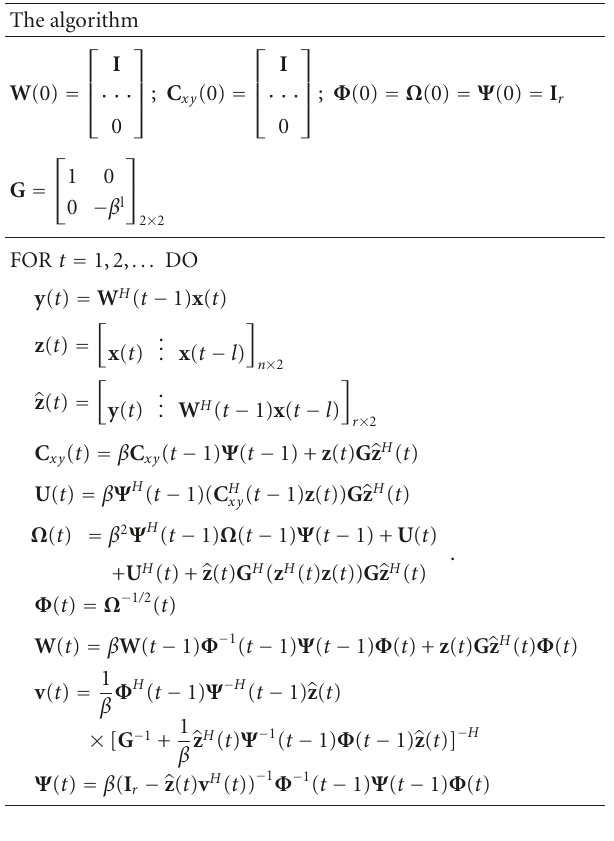
Table 2: Truncated window CPAST